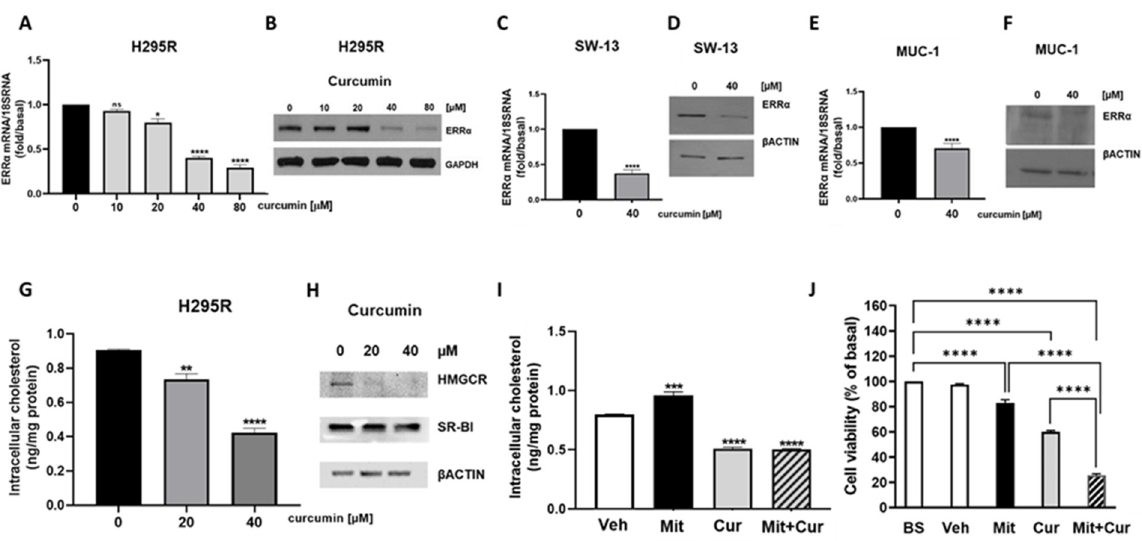
Figure 5. Curcumin reduces ERR α expression and Cholesterol content in ACC cells. ( A – F ) ACC cells were treated with the indicated doses of curcumin for 24 h and ERR α mRNA and protein expression were assessed by real ‐ time RT ‐ PCR ( A , C , E ) and Western blotting analysis ( B , D , F ). ( G , I ) Colorimetric assay was used to measure cholesterol extracted from H295R cells treated for 24h as follows: ( G ) curcumin (0, 20, 40 μ M) and ( I ) vehicle (veh, DMSO), Mitotane (Mit, 10 μ M), curcumin (Cur 40 μ M) and their combination (Mit + Cur). ( H ) Western blotting of HMGCR and SR ‐ BI in curcumin ‐ treated H295R cells. ( J ) H295R cells were untreated (basal, BS), treated with vehicle (veh, DMSO), Mitotane (Mit, 10 μ M), curcumin (Cur 40 μ M) and their combination (Mit + Cur) 48 h. Cell viability was evaluated by MTT assay. Data and images are from at least three independent experiments. (* p < 0.05; ** p < 0.01; *** p < 0.001; **** p < 0.0001 vs. 0 μ M; ns: not significant).